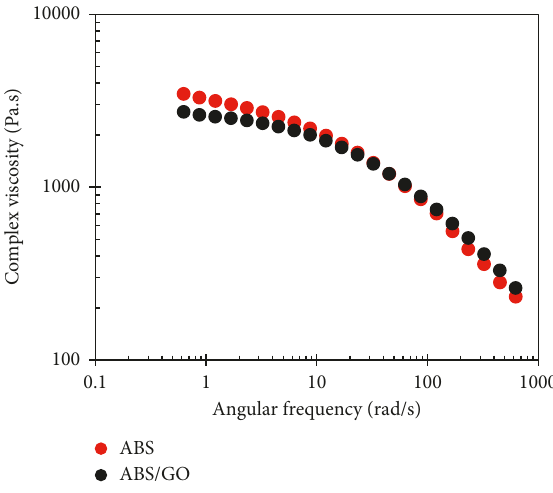
Figure 10: Complex viscosity versus the angular frequency for the ABS filament and the ABS/GO composite filament. ) and loss modulus (G ) versus the ′ ″